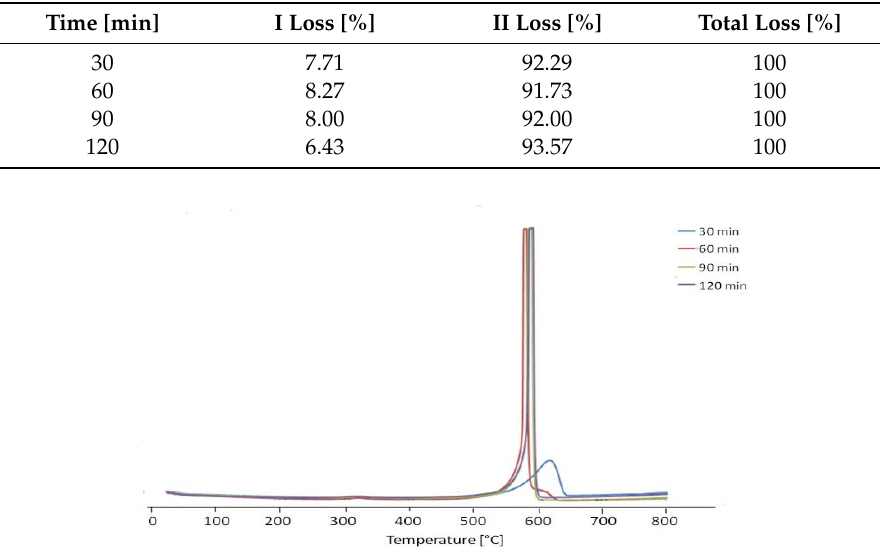
Figure 13. TG curves of purified MWCNTs after adsorption of 10 mL of solution of 37 mg/L of Reactive Black 5 at different treatment times. Table 4. Weight losses of purified MWCNTs after adsorption of 10 mL of solution of 37 mg/L of Reactive Black 5 at different treatment times.